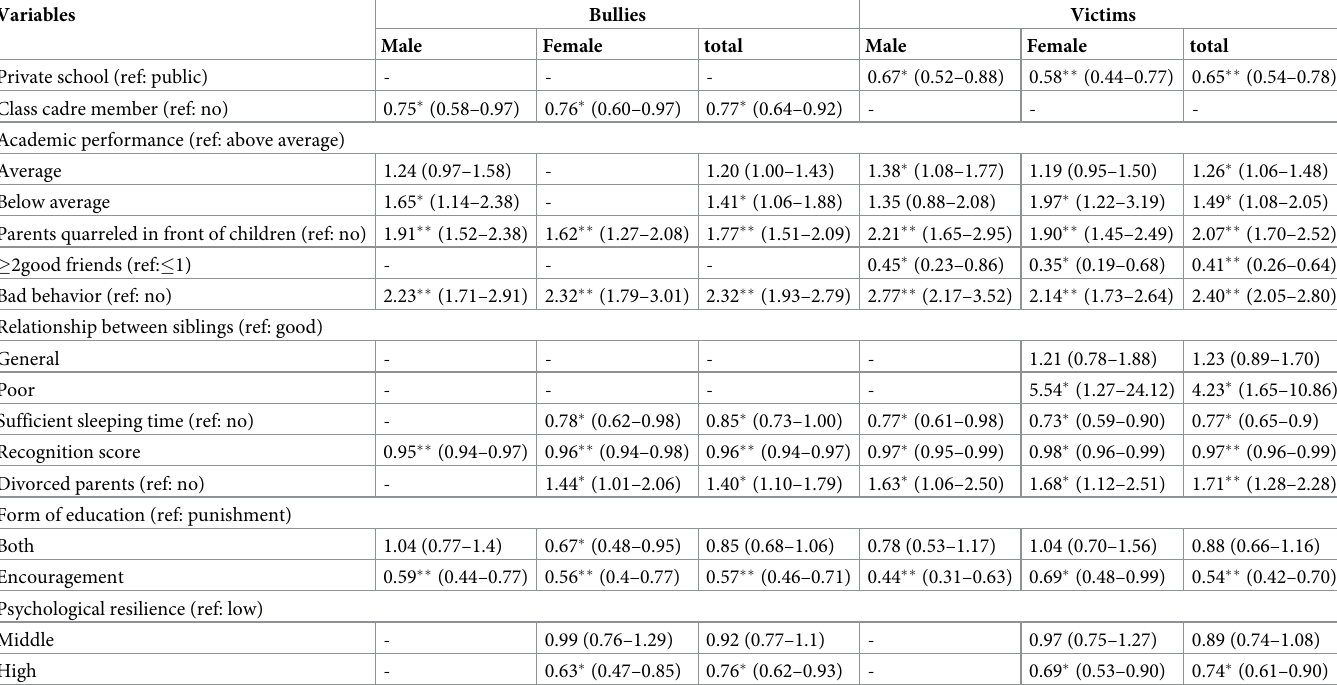
Table 4. Binary logistic regression of school bullying (OR (95% CI)). Variables